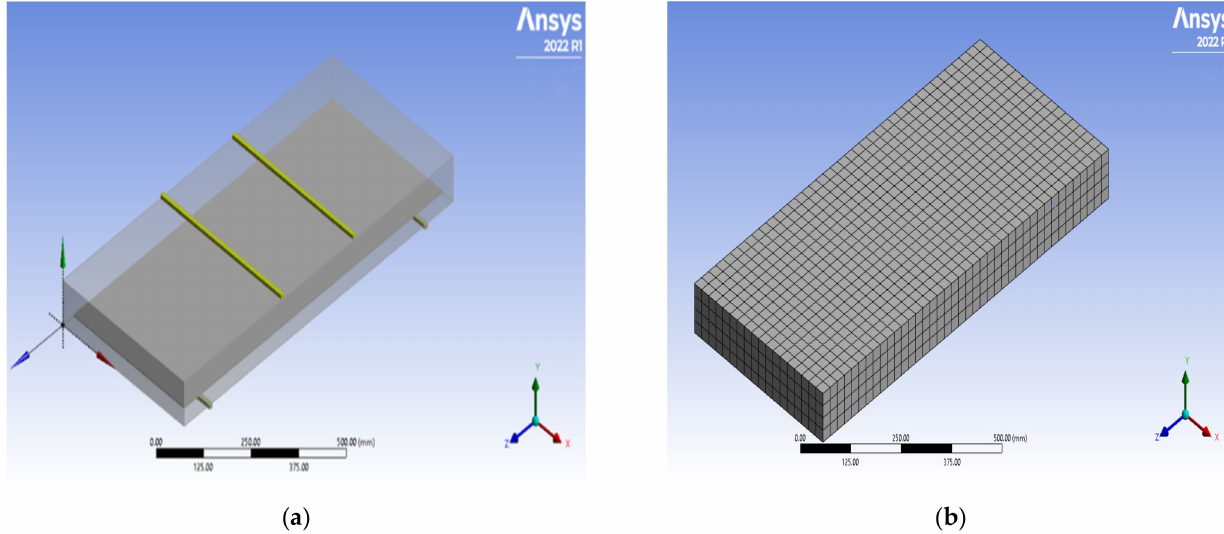
Figure 20. Slab specimen ( a ) Geometry and ( b ) 3D meshed